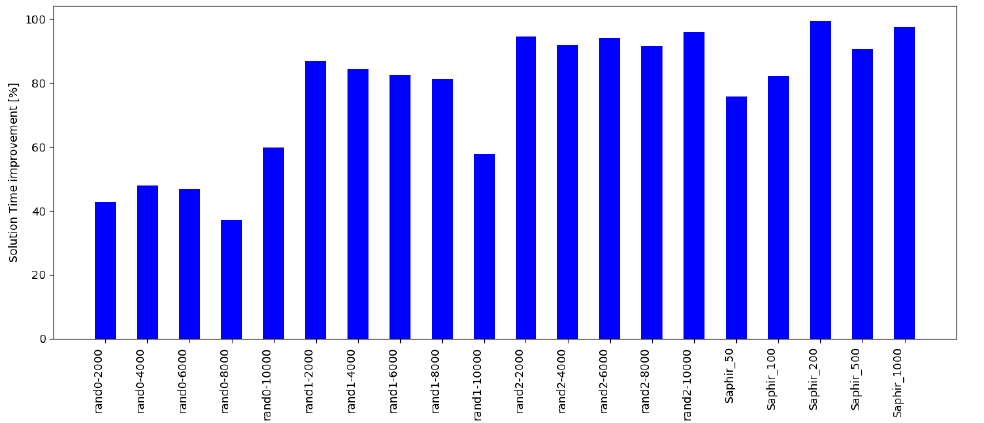
Figure A1. Maximum relative improvement of the solution time by using FortSP’s solvers over DECIS’s